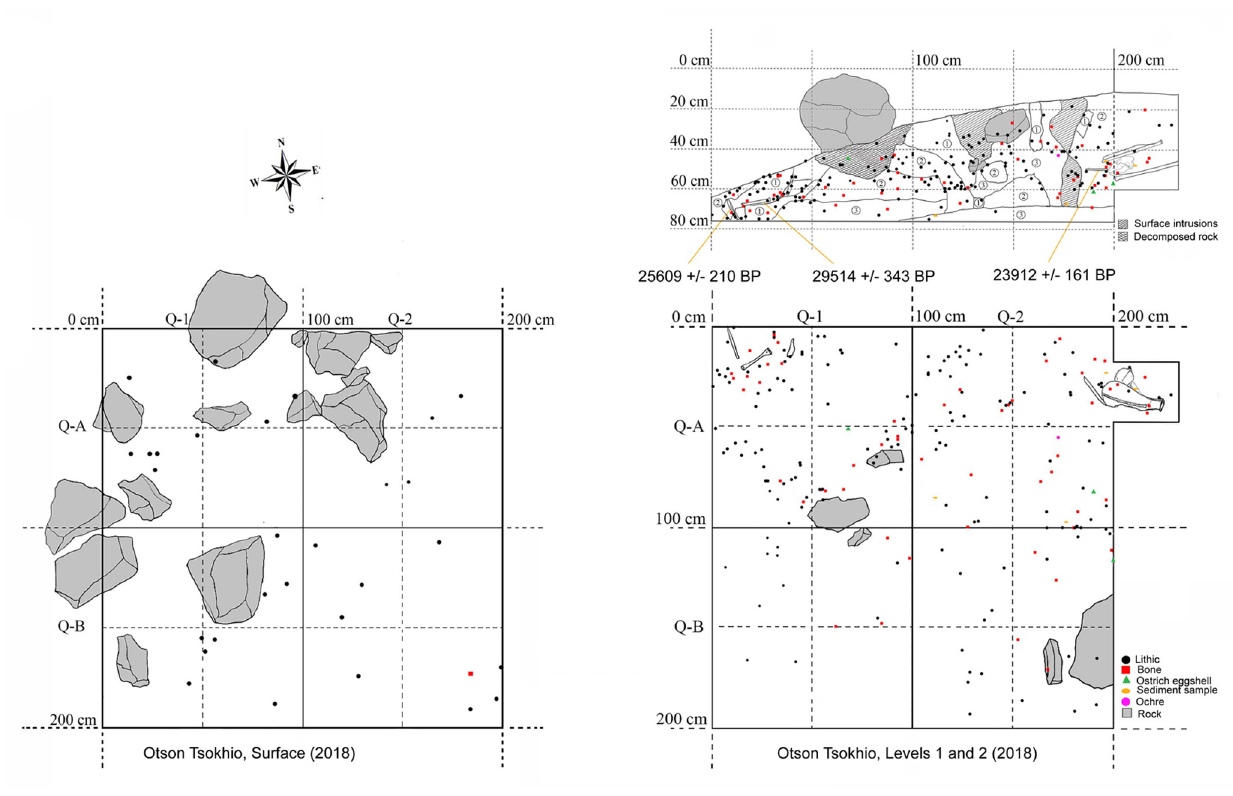
Fig 7. Map of 2018 excavation at Otson Tsokhio.